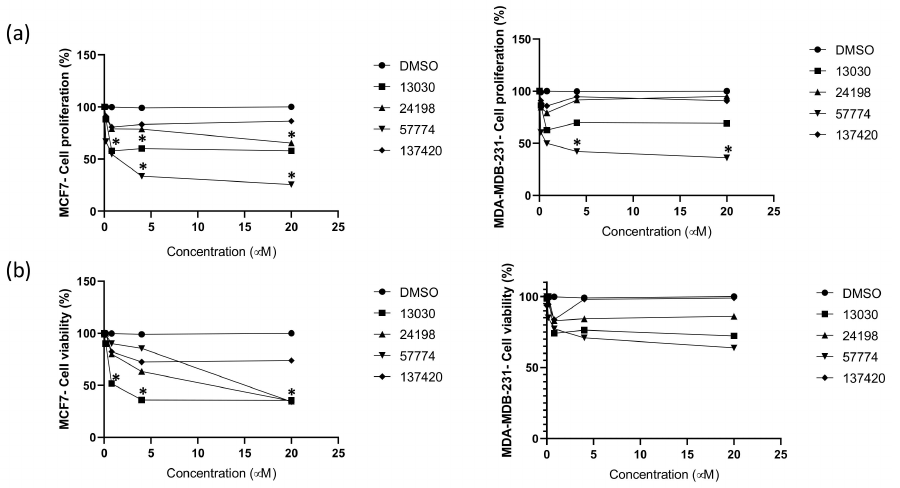
Figure 4. The effect of the compounds NSC 13030 , 24198 , 57774 , and 137420 on MCF-7 and MDA- MB-231 proliferation ( a ) and viability ( b ). Cells were incubated with increasing concentrations of compounds in culture medium for 48 h. The viability and the proliferative response were assessed. Data presented are the mean ± SEM of three independent experiments. * p < 0.05. Continuous lines are for compounds, and dashed lines are for the vehicle DMSO.